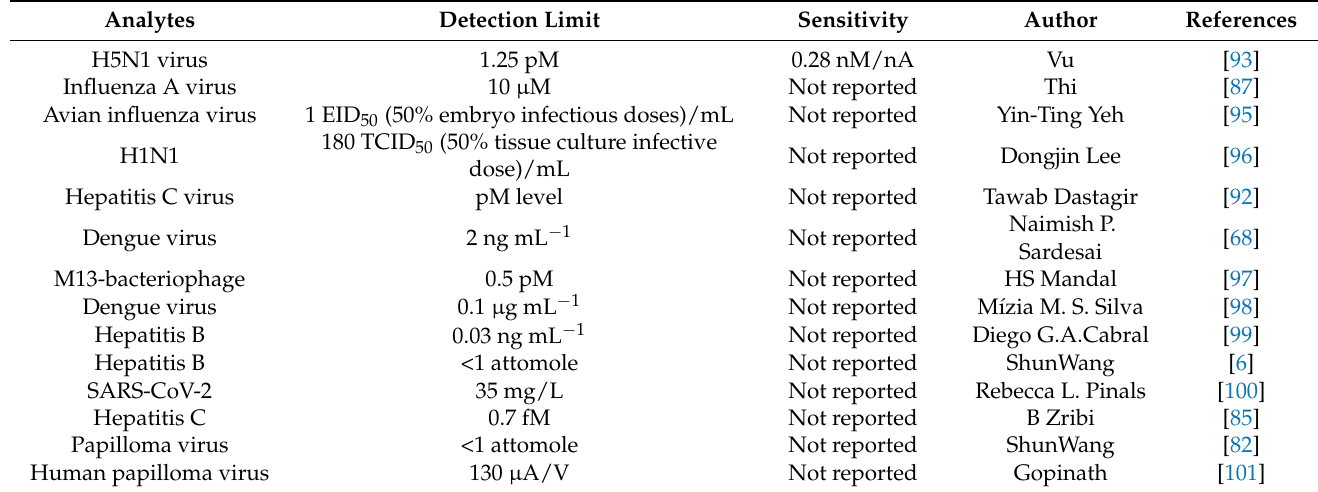
Table 4. The research on CNTFET for virus